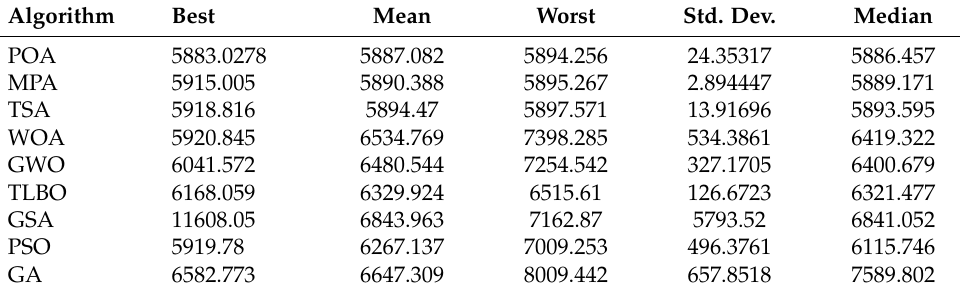
Table 10. Statistical results for a pressure vessel design